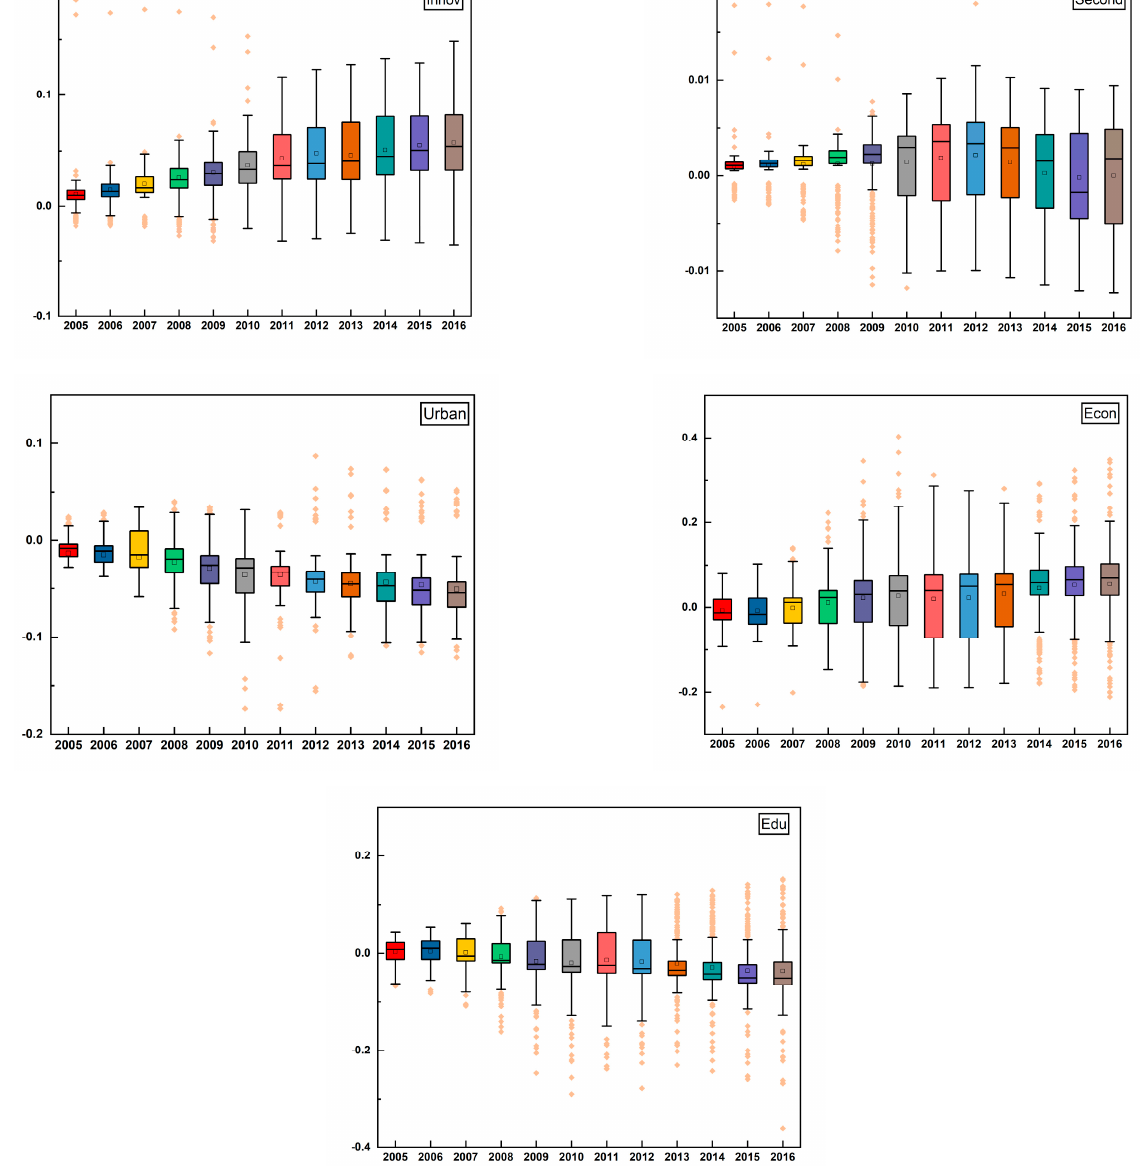
Figure 3. Box plots of the estimated coefficients of control variables from 2005 to